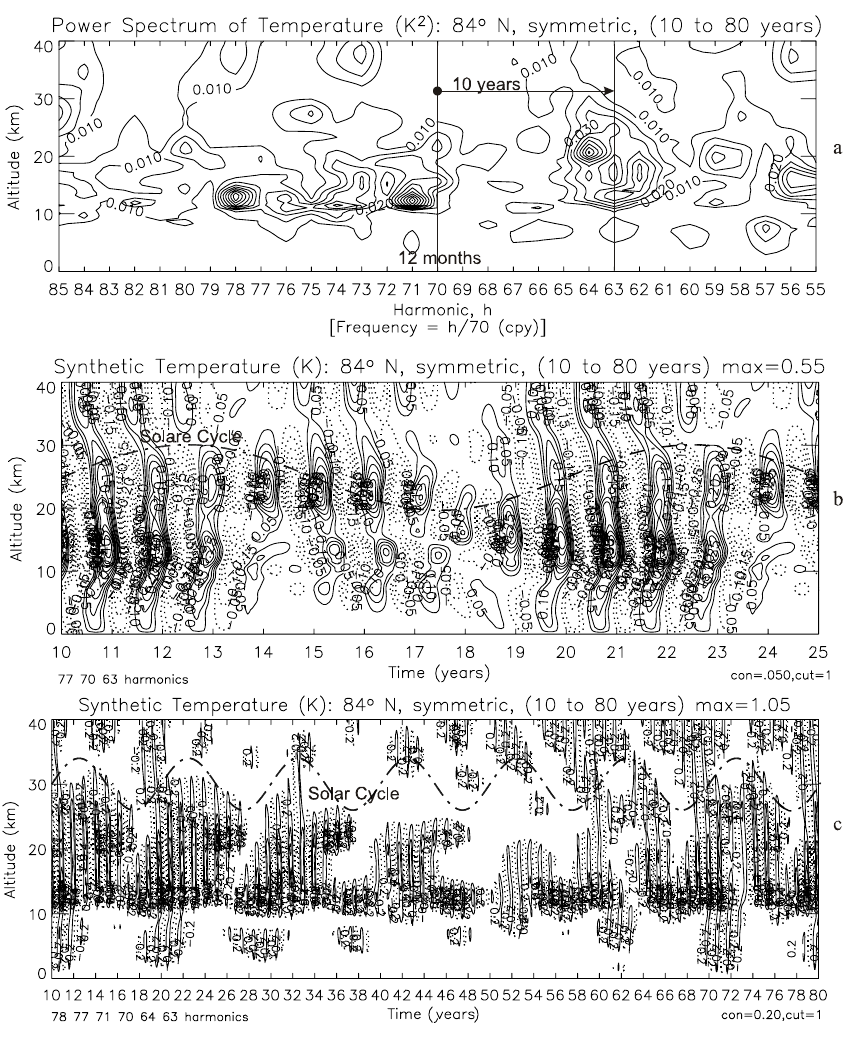
Fig. 9. Similar to Fig. 6 but for the temperature variations at polar latitudes, which are associated with the EAO zonal winds. In (a) , the 12-month oscillation is identified at h =70 together with the corresponding SC side lobe, and the synthesis is presented in (b) . As in Fig. 6, the amplitude maximum in (a) occurs at h =71 instead of 70, shifted by one wave number to indicate the 70-year variability. The synthesis in (c) then describes the SC modulation of the symmetric annual oscillation over the 70-year time